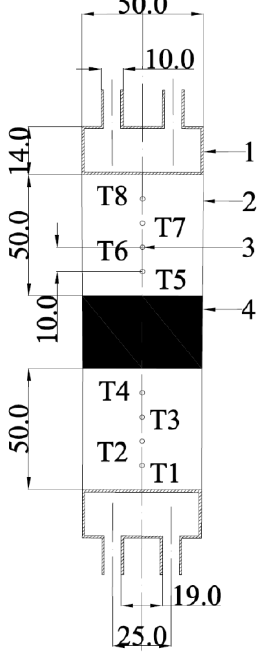
Figure 2. Schematic diagram and parameters of the test section. (1) Copper container, (2) fluxmeter, (3) platinum resistance thermometer and (4) sample to be tested (unit: mm).